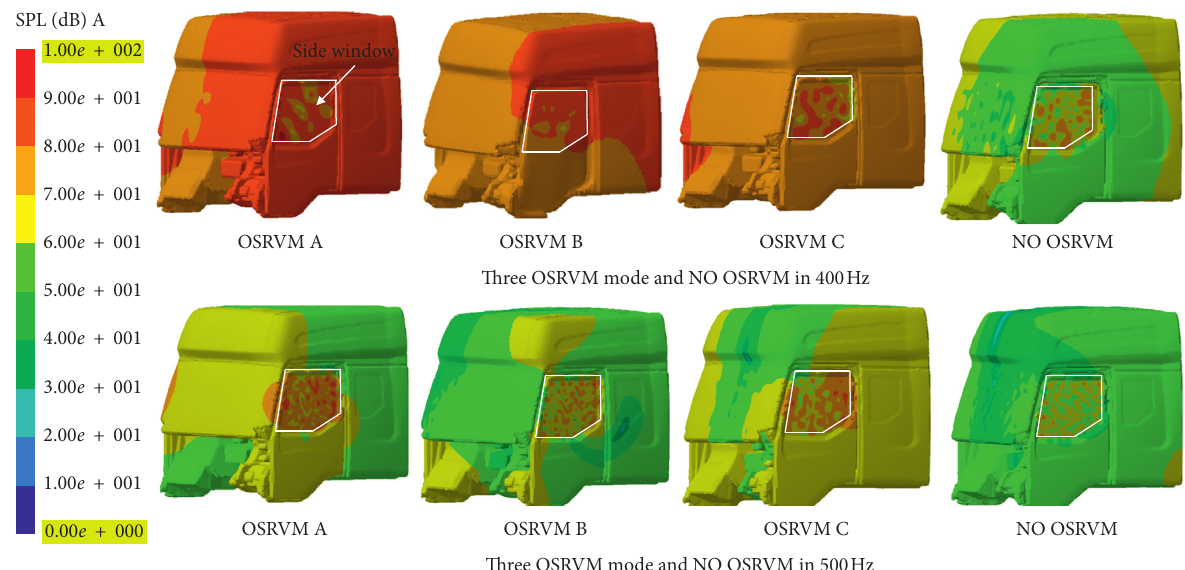
Figure 11: The distribution of the sound pressure level of four statuses in the cab cavity.